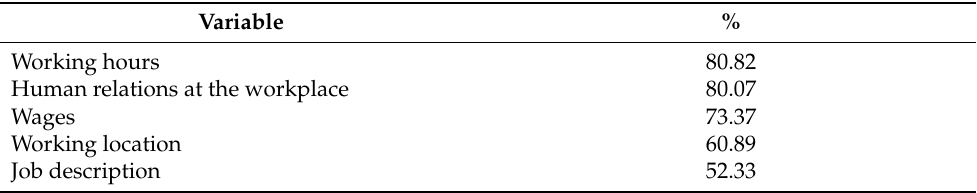
Table 2. Prioritized variables of the subjects according to the survey results.